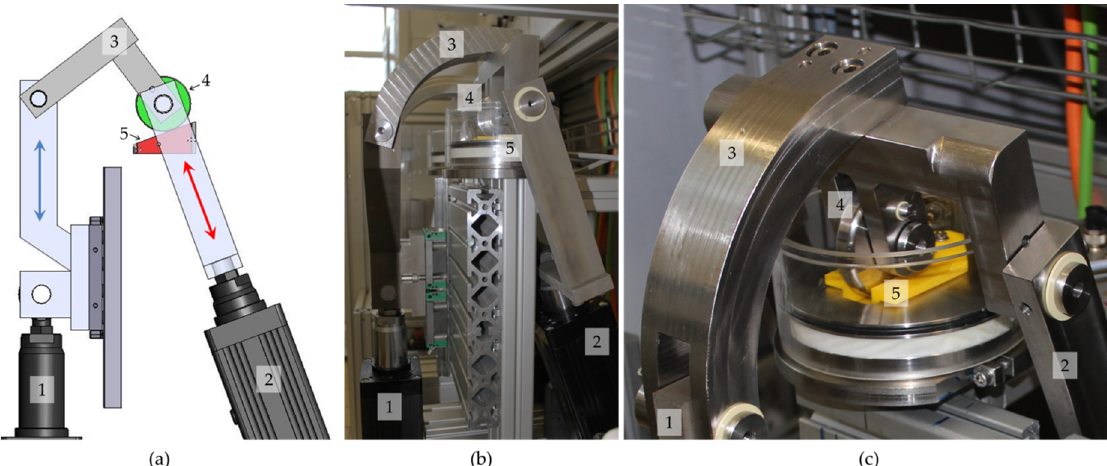
Figure 1. Rolling-sliding test bench ( a ) initially developed by Goebel et al. [7]; ( b ) enhanced with a second station and tempered testing chamber ( c ); with a lifting cylinder and linear guide (1, blue arrow indicates the direction of movement), pivoted force cylinder (2, red arrow indicates the direction of applied forces), right-angled lever (3), rolling cylinder (4, CoCr) with a rotation lock pin, and the sample on an inclined plane fixed with a yellow clamp (5).